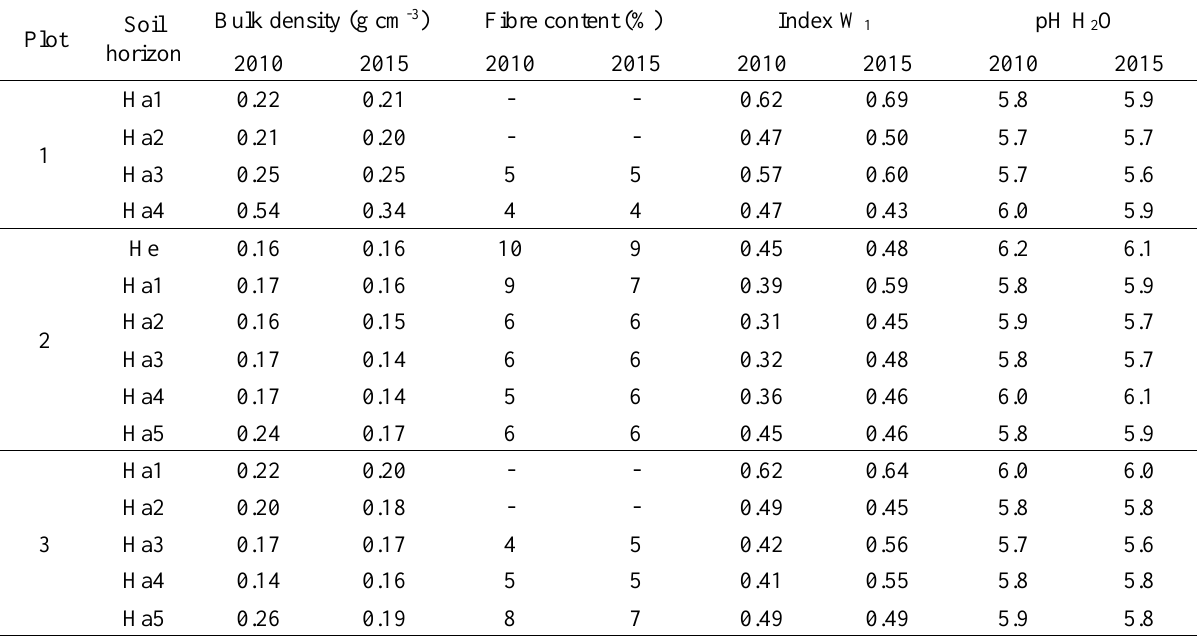
Table A2. Soil physical and physicochemical properties (mean values) of soil horizons.